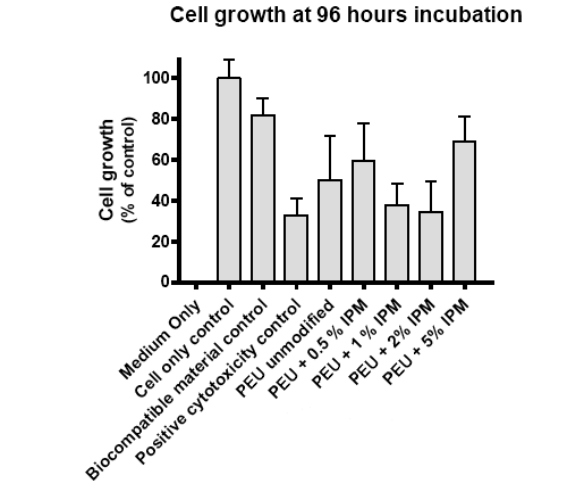
Figure 7. Relative cell growth on PEU-1 series at 96 hours. (n = 12 for controls and 6 for test